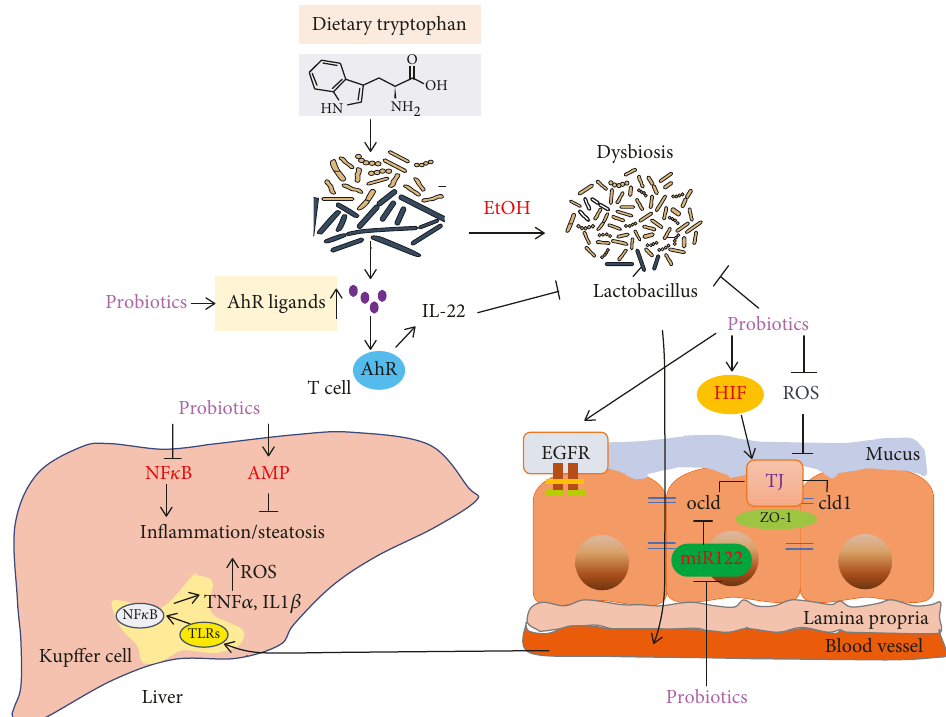
Figure 2: Probiotics function in gut-liver mechanisms. Probiotics and related products prevent ethanol-induced e ff ects in the intestine and the liver via multiple mechanisms: (1) enhancement of antioxidant activity; (2) reduction of in fl ammatory cytokine expression; (3) hepatic AMPK and induction of lipid metabolism; (4) enhancement of intestinal tight junction ZO-1, claudin-1, and occludin expression via increased intestinal HIF signaling; (5) inhibition of miR122a expression leading to occludin upregulation; (6) activation of EGFR and preservation of barrier function in intestinal epithelial cells; and (7) positive modi fi cation of gut microbiota and increase AhR